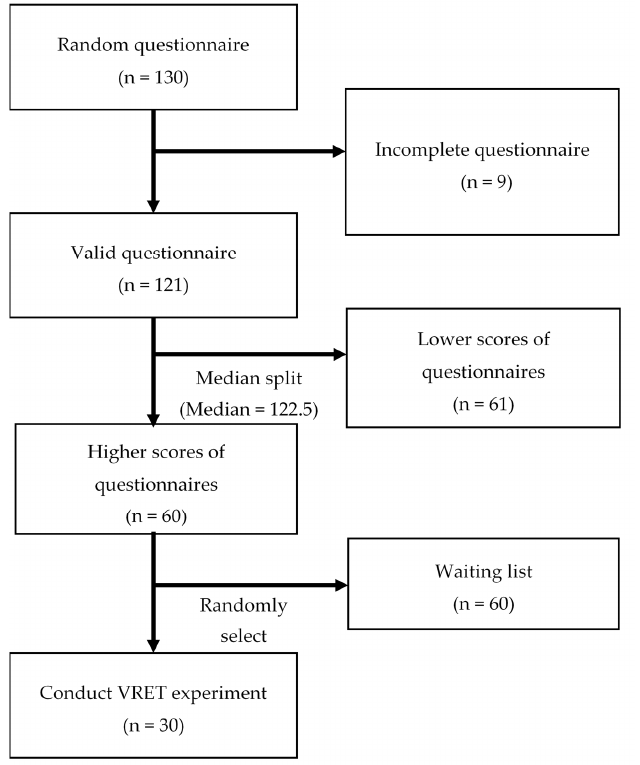
Figure 4. Subject selection flow